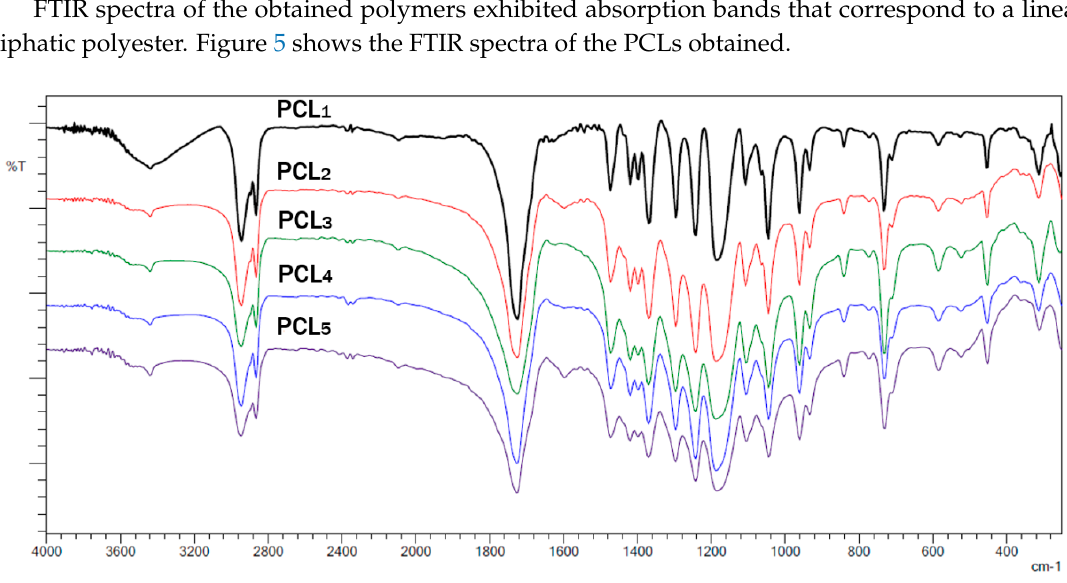
Figure 5. FTIR spectra of the PCLs obtained using 1 – 5 .